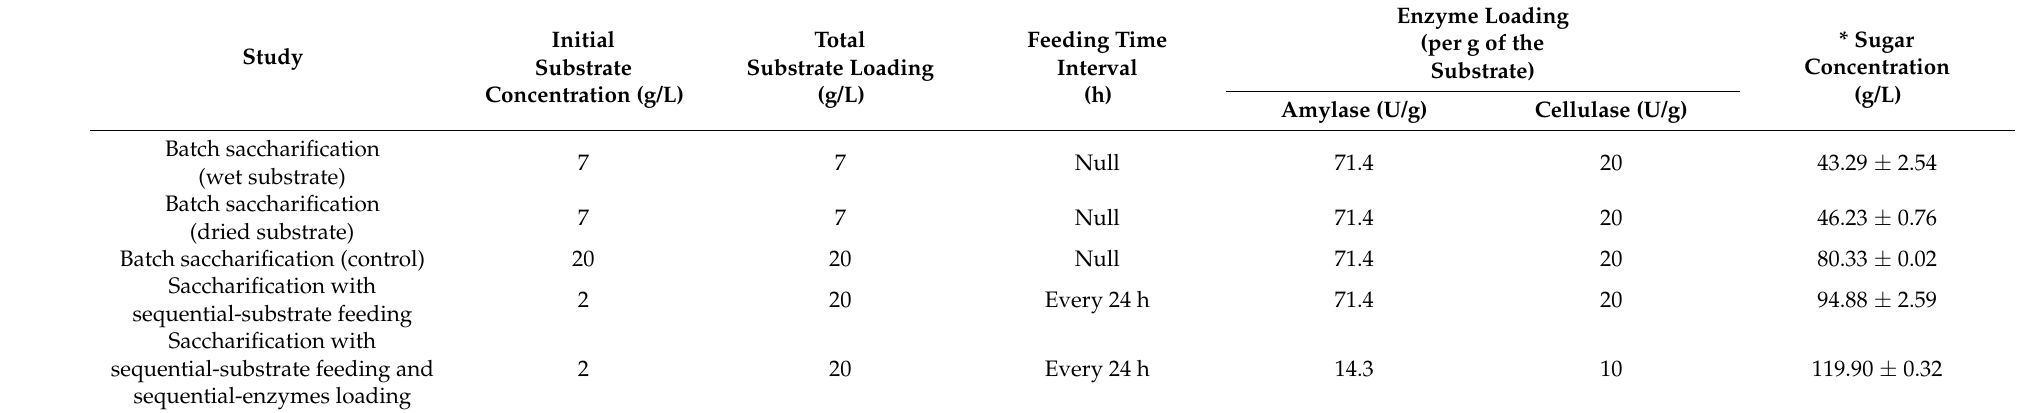
Table 4. Comparison of sugar production between different strategies of saccharification using sago hampas as a